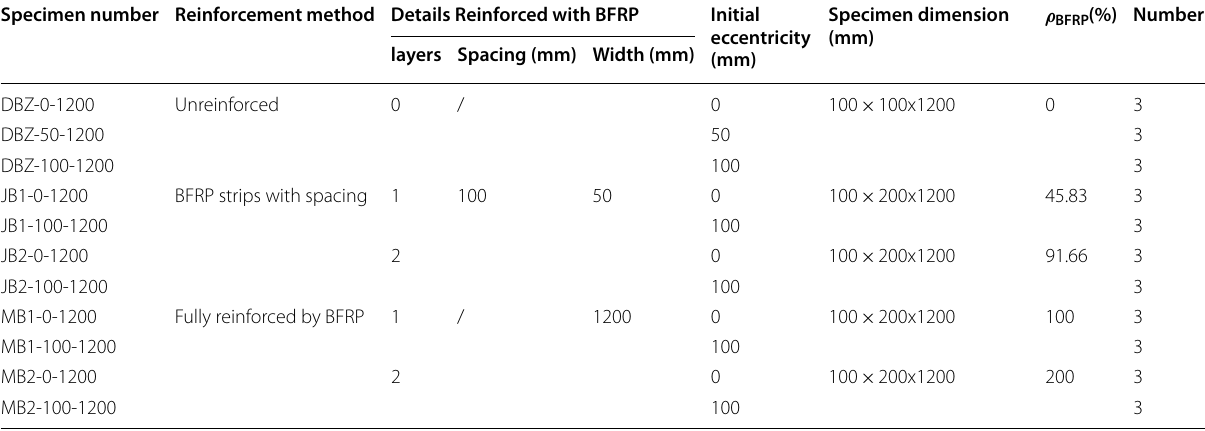
Table 4 The basic parameters of the specimen Specimen number Reinforcement method Details Reinforced with BFRP Initial